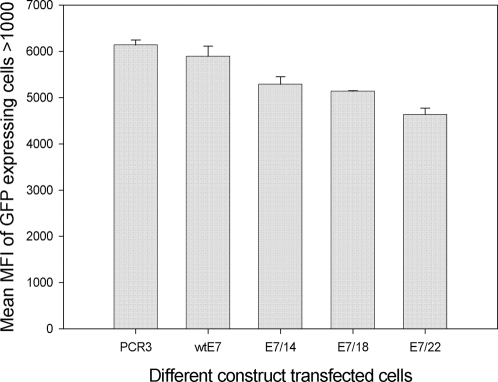
Analysis of expression of EGFP, used as a control for transfection efficiency.Expression of EGFP was detected in all cells cotransfected with E7 genes and an EGFP expression construct. All transfections were done in duplicate. The amount of protein expressed declined with increasing numbers of optimized codons in the E7 genes suggesting down regulation due to expression of E7 (p<0.05, unpaired student t test).